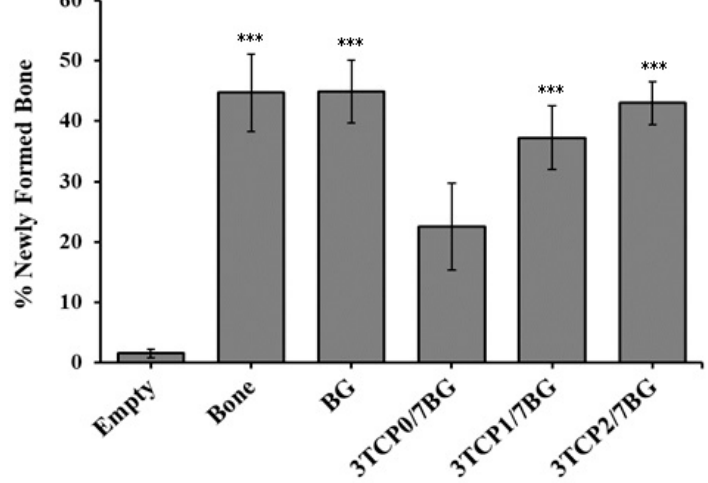
Figure 8. Percentages of newly formed bone in bone defects 9 weeks after treatment and after excision. The Figure represents the mean ± standard deviation of at least 5 independent experiments. Significant differences relative to empty group are identified with the use of *** that represents p < 0.001.